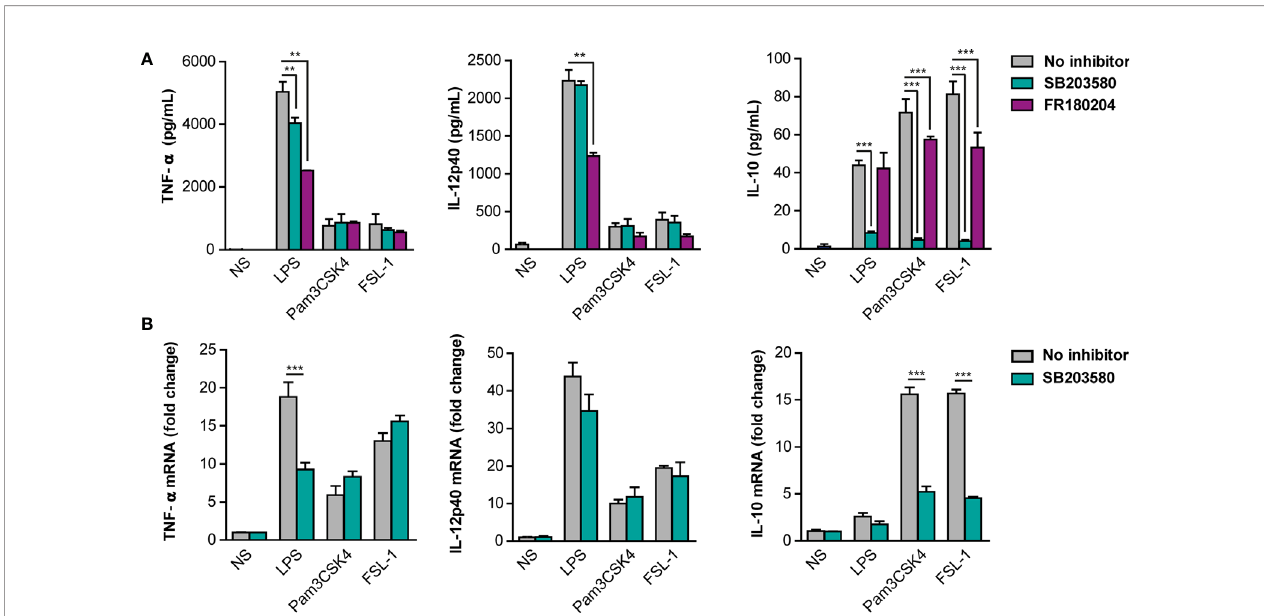
FIGURE 6 | Differential contribution of p38 and ERK for cytokine production in response to TLR ligands. Peritoneal macrophages were pre-treated with 10 µM SB203580 or 10 µM FR180204 for 30 min and then stimulated with LPS (100 ng/mL), Pam3CSK4 (1 µg/mL) and FSL-1 (100 ng/mL) for 24 hours. (A) Cytokine protein levels and (B) Cytokine mRNA levels were measured by ELISA and qPCR respectively. Data from triplicate cultures (mean ± SEM.) are representative of one of the three independent experiments performed (**p < 0.01 and ***p <